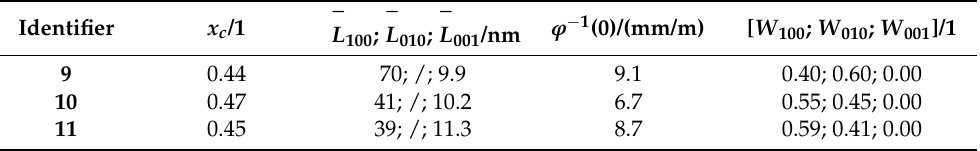
Table 1. Structural characteristics obtained using XRD: crystallinities xc, average crystallite sizes L , microstrain distribution ϕ − 1 ( 0 ) and directional weighting factors W hkl